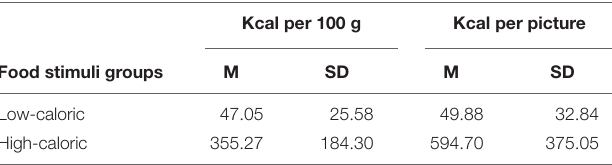
TABLE 2 | Study 2 means (M) and standard deviation (SD) Kcal per 100 g and Kcal per picture for each of the two groups of food stimuli constituted. Kcal per 100